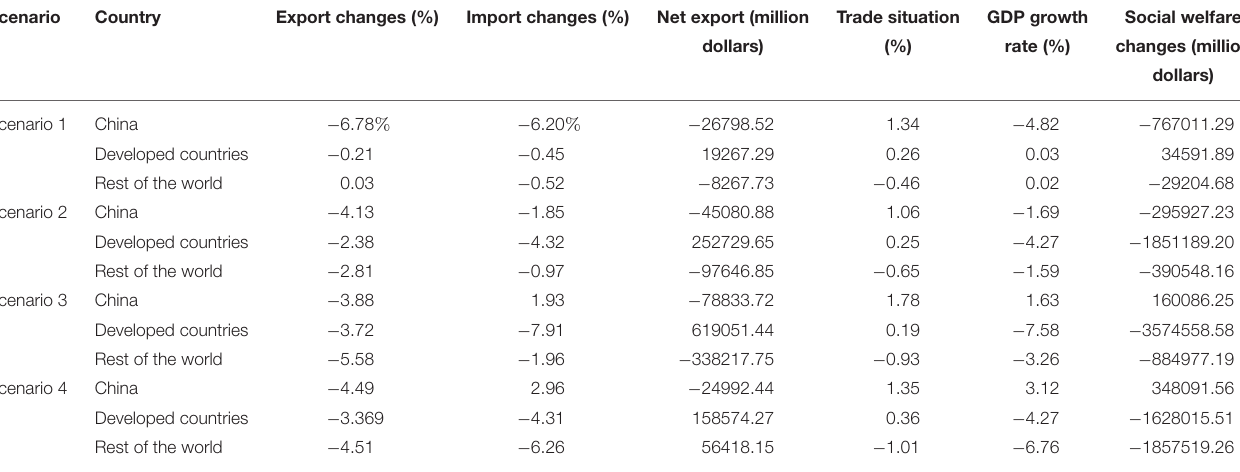
TABLE 2 | The pandemic’s impact on China and other economies. Scenario Country Export changes (%) Import changes (%) Net export (million Trade situation GDP growth